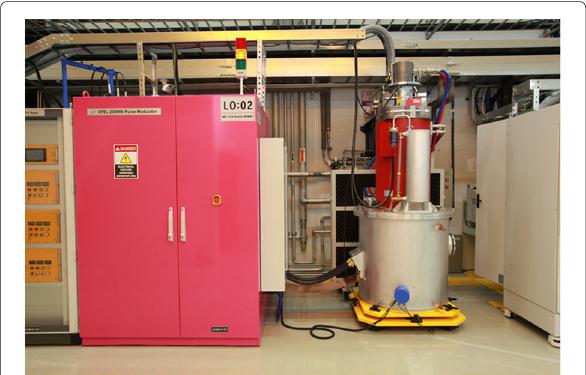
Fig. 4 The modulator and klystron for